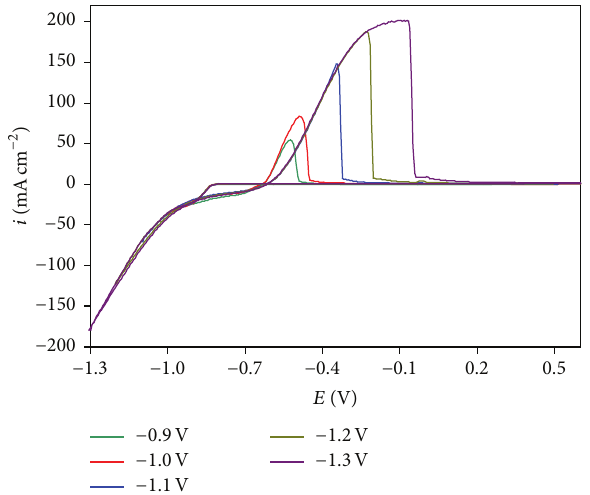
Figure 6: The current responses of dissolution of silver to different cathodic vertex potentials in the solution containing high potassium cyanide electrolyte. Electrolyte: 40 g/L KCN, 120 g/L KAg(CN) 2 , and 120 g/L KNO 3 . Initial potential: +0.6